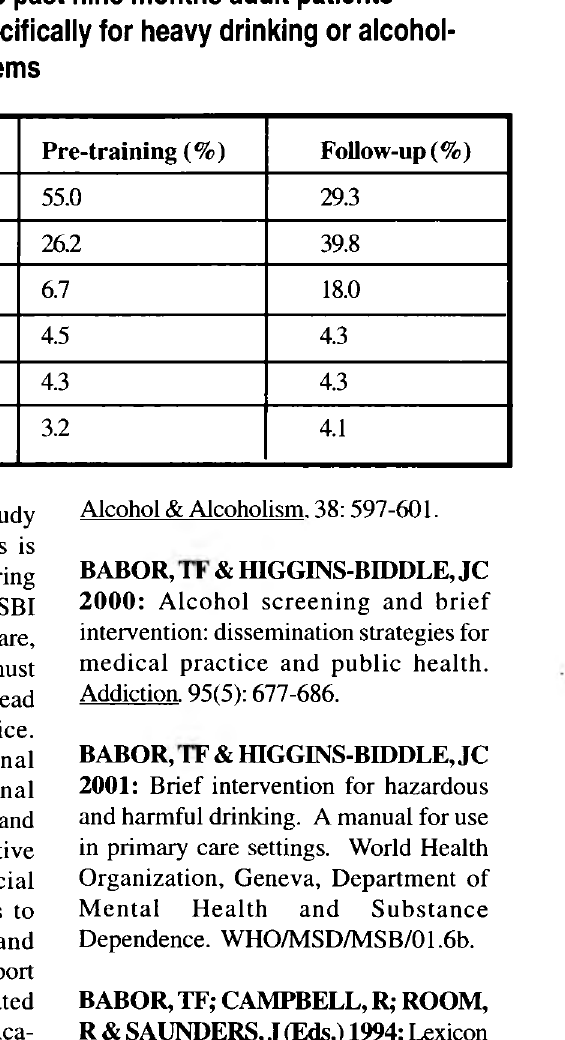
Table 2: In the past nine months adult